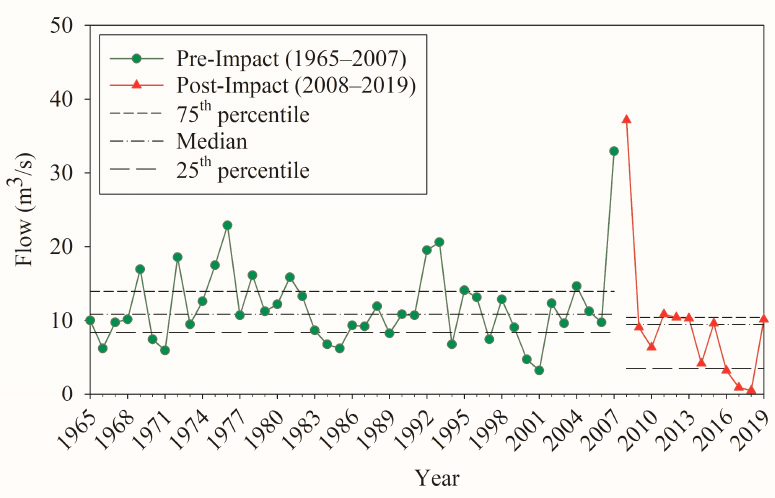
Figure 4. Changes in the average monthly flow of the Kor River at Chamriz station due to the construction of the Mollasadra Dam. ( a ) pre-impact period (1965–2007) and ( b ) post-impact period (2008–2019).